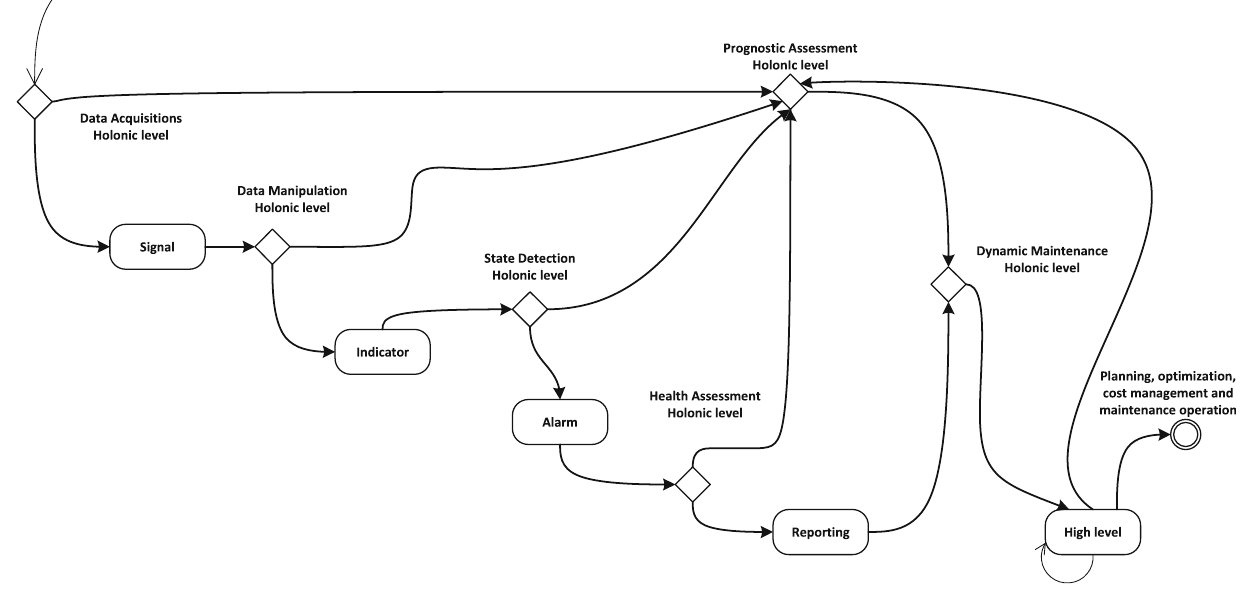
Fig. 9 Model of a SurfEvent life